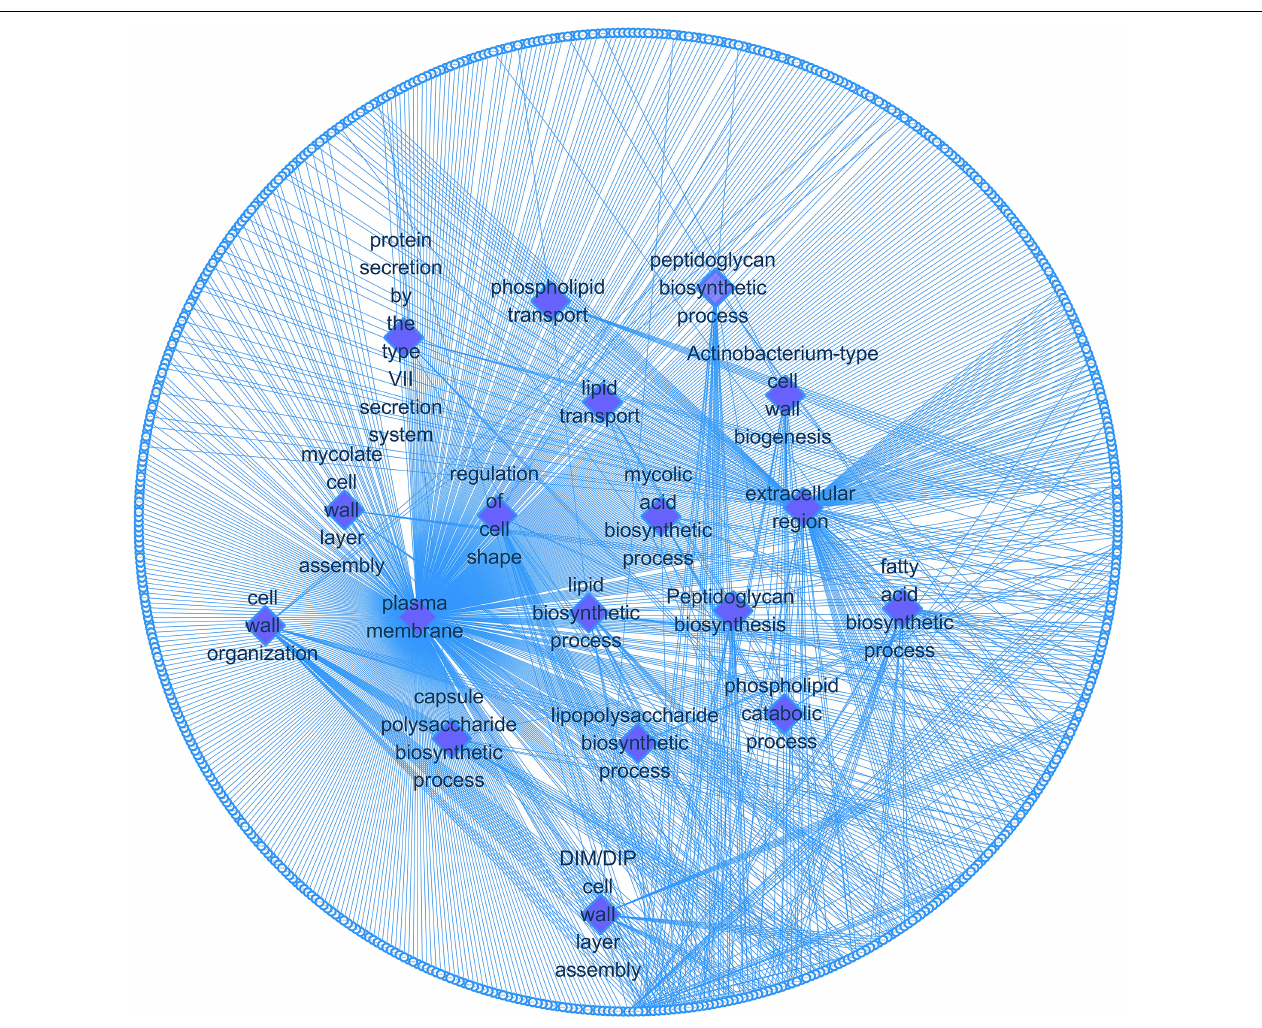
FIGURE 5 | Cell wall synthesis gene and gene function regulatory network. Diamond-shaped nodes and rectangular nodes, respectively, represent gene functions and genes related to cell wall